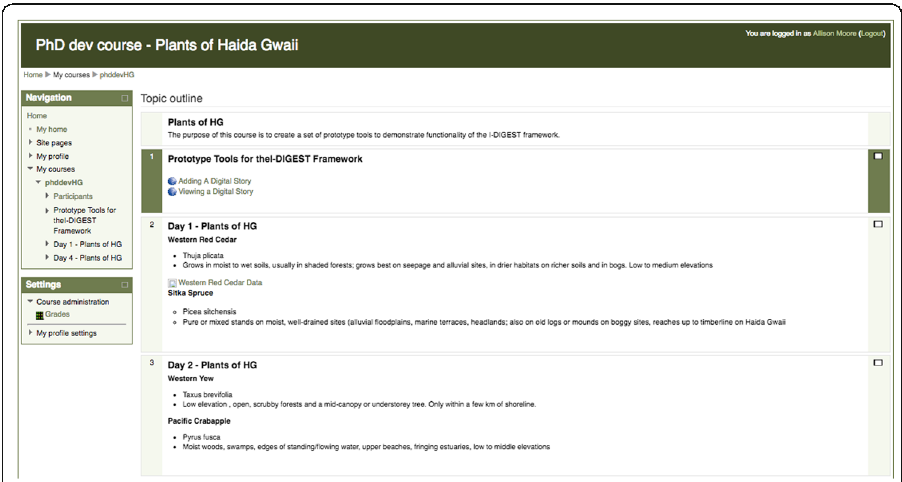
Fig. 3 LMS course for Plants of Haida